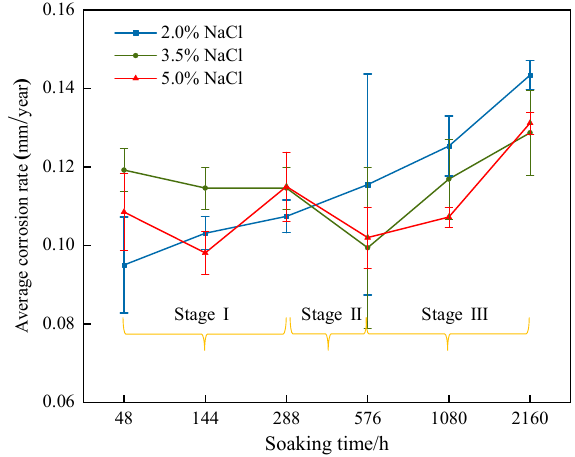
Figure 1. Average corrosion rate of ER8 wheel steel.